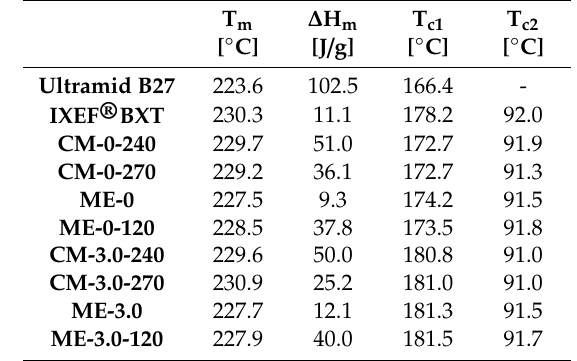
Table 2. Melting temperatures (T m ), crystallization enthalpies ( ∆ H m ), and crystallization temperatures (T c ) of virgin polymers and films with 0 wt.-% and 3.0 wt.-% filler.